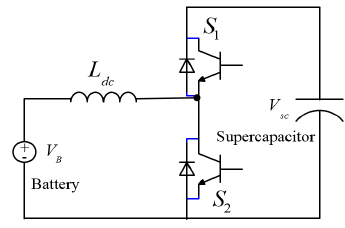
Figure 2. The structure of the hybrid energy storage system.